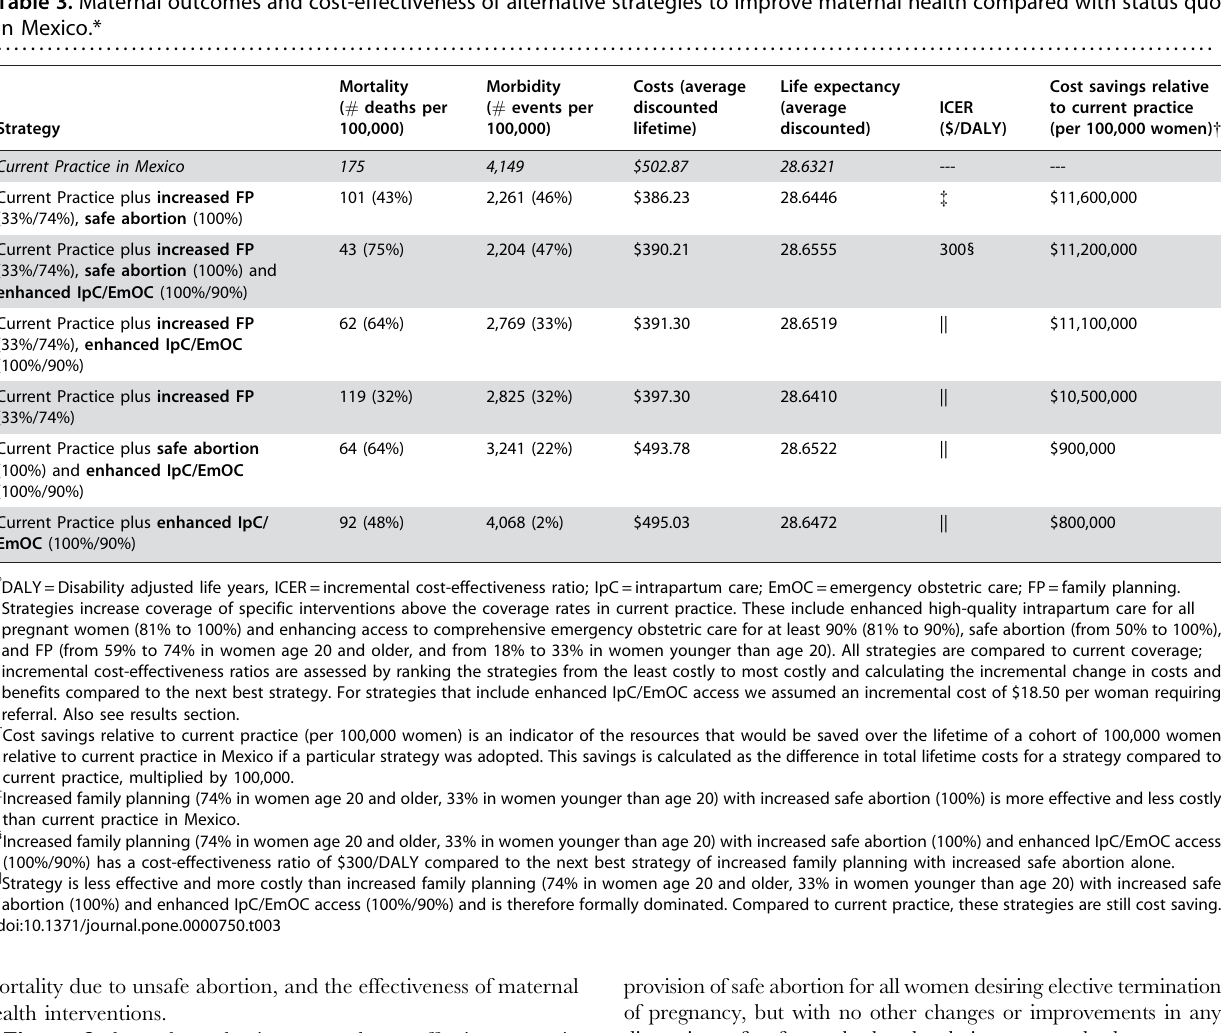
Table 3. Maternal outcomes and cost-effectiveness of alternative strategies to improve maternal health compared with status